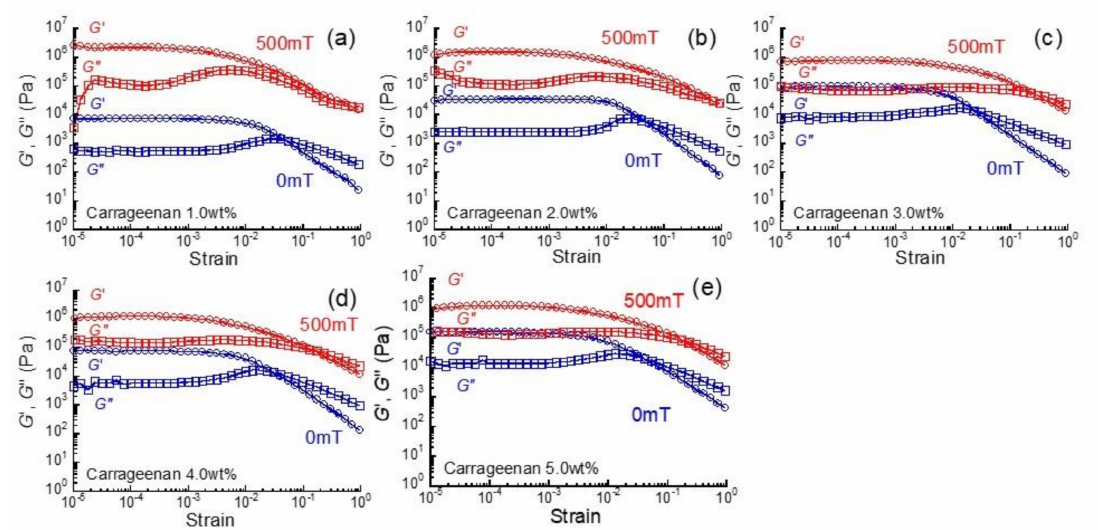
Figure 1. Strain dependence of storage modulus and loss modulus at 0 mT and 500 mT for magnetic hydrogels with various carrageenan concentrations (carbonyl iron (CI): 70 wt%, f = 1 Hz). ( a ) 1.0 wt%, ( b ) 2.0 wt%, ( c ) 3.0 wt%, ( d ) 4.0 wt%, ( e ) 5.0